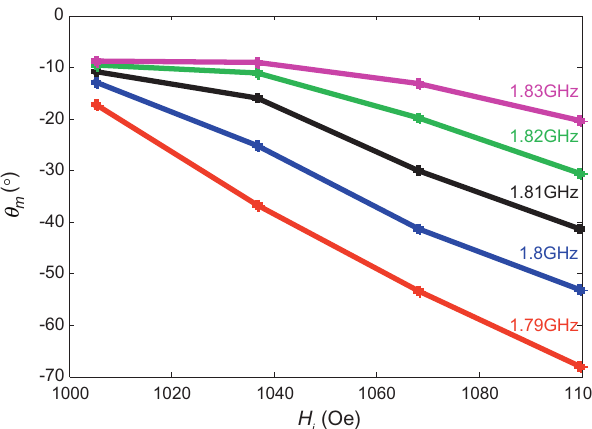
Figure 7. Scan angle h m plotted versus the bias field H i for different frequencies. Calculations were done using (2) and the dispersion curves were extracted via full-wave simulations.